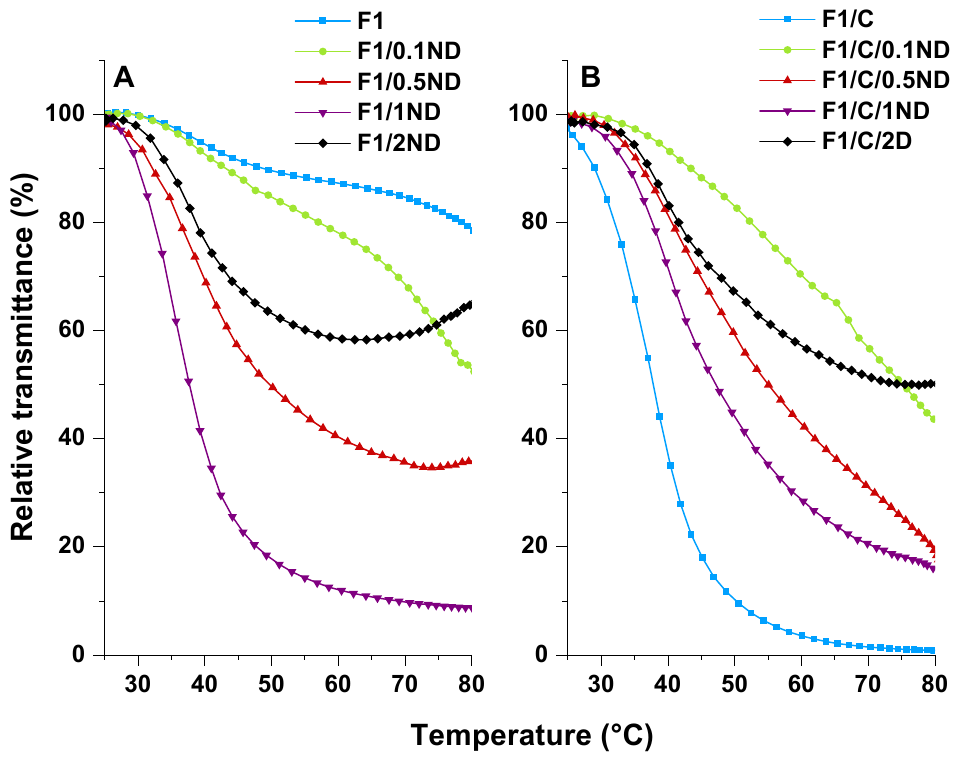
Figure 9. Relative transmittance of the ( A ) F1 films and the ( B ) F1/C films immersed in a pH 10 buffer.